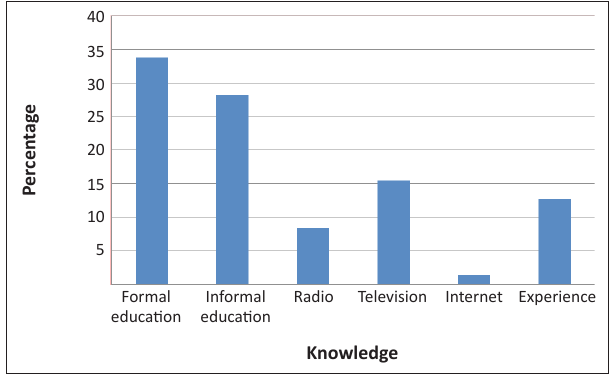
FIGURE 3: Educational qualifications of respondents.